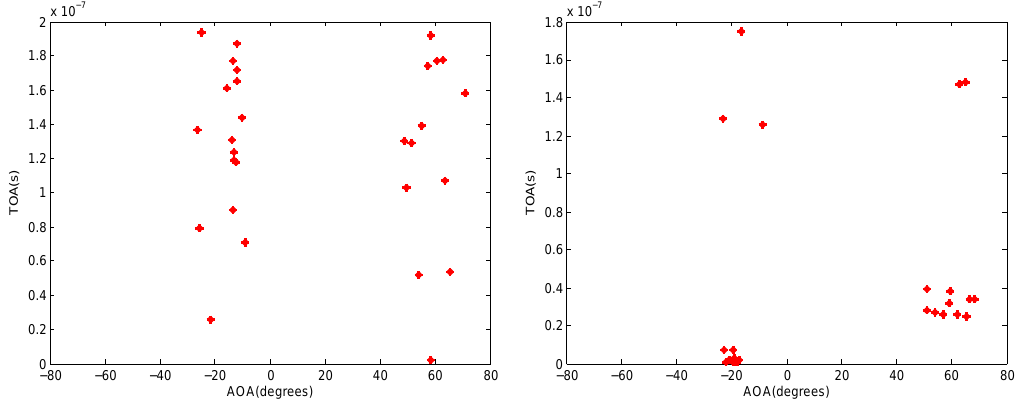
Figure 8. Results of AOA and TOA